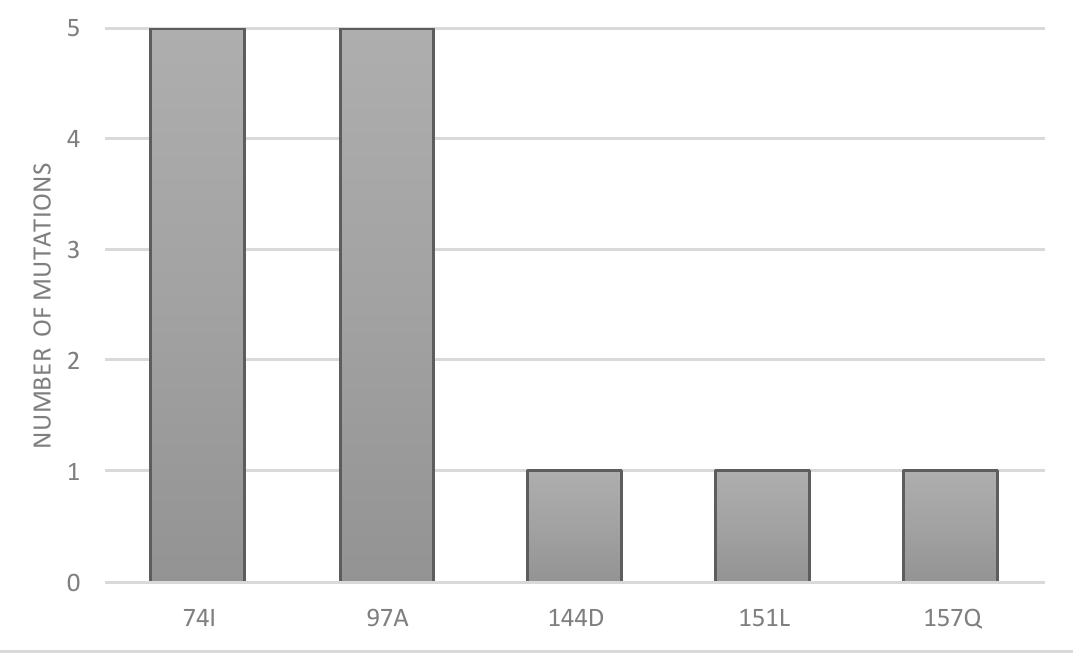
Figure 5. Observed frequency of mutations conferring resistance to integrase strand transfer inhibitors (INSTIs).